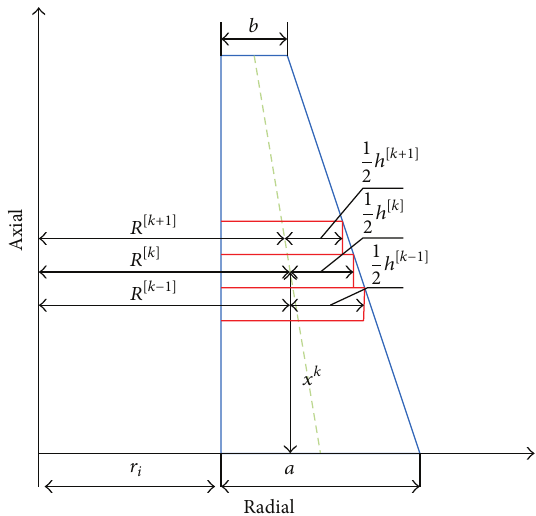
Figure 2: Dividing of thick cylinder with variable thickness to disk form multilayers.